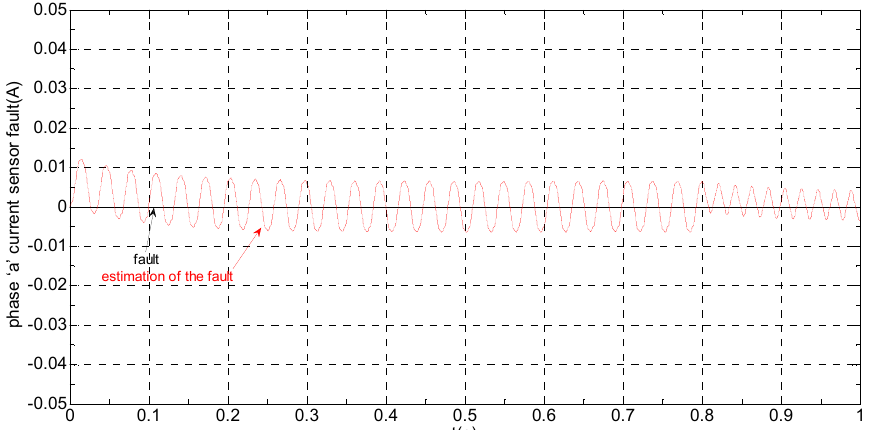
Figure 5. The actual and estimated value of i β .